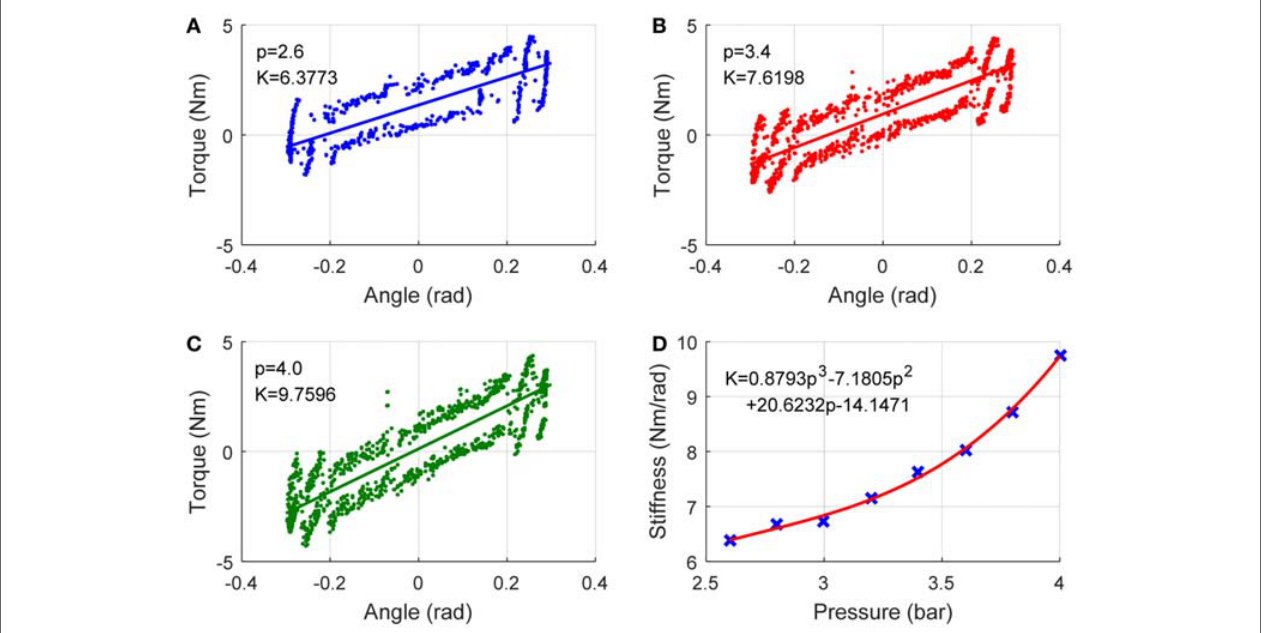
FIGURE 4 | Robot inherent compliance adapted by nominal pressure about X (DP) axis. (A–C) the robot toque vs angle (to get stiffness K x rob ) under three different pressures and (D) robot stiffness as a function of pressure, where the crosses denote seven pairs of robot stiffness vs pressure.